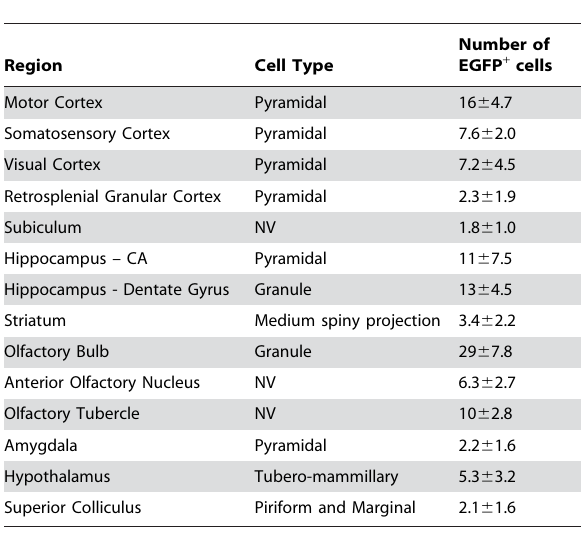
Table 1. Recombination efficiencies in various areas of the adult